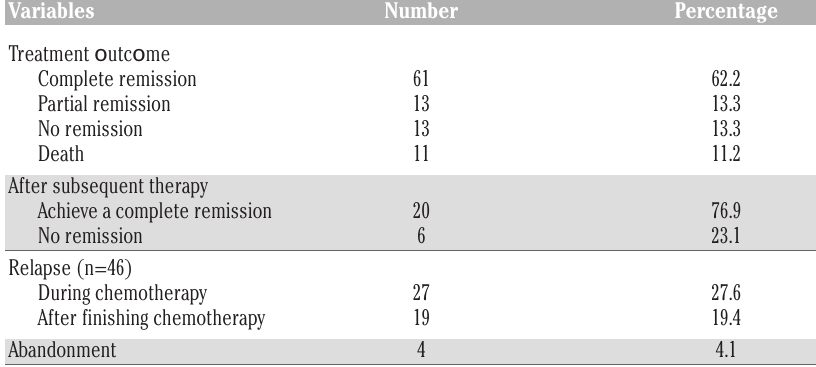
Table 4. Treatment